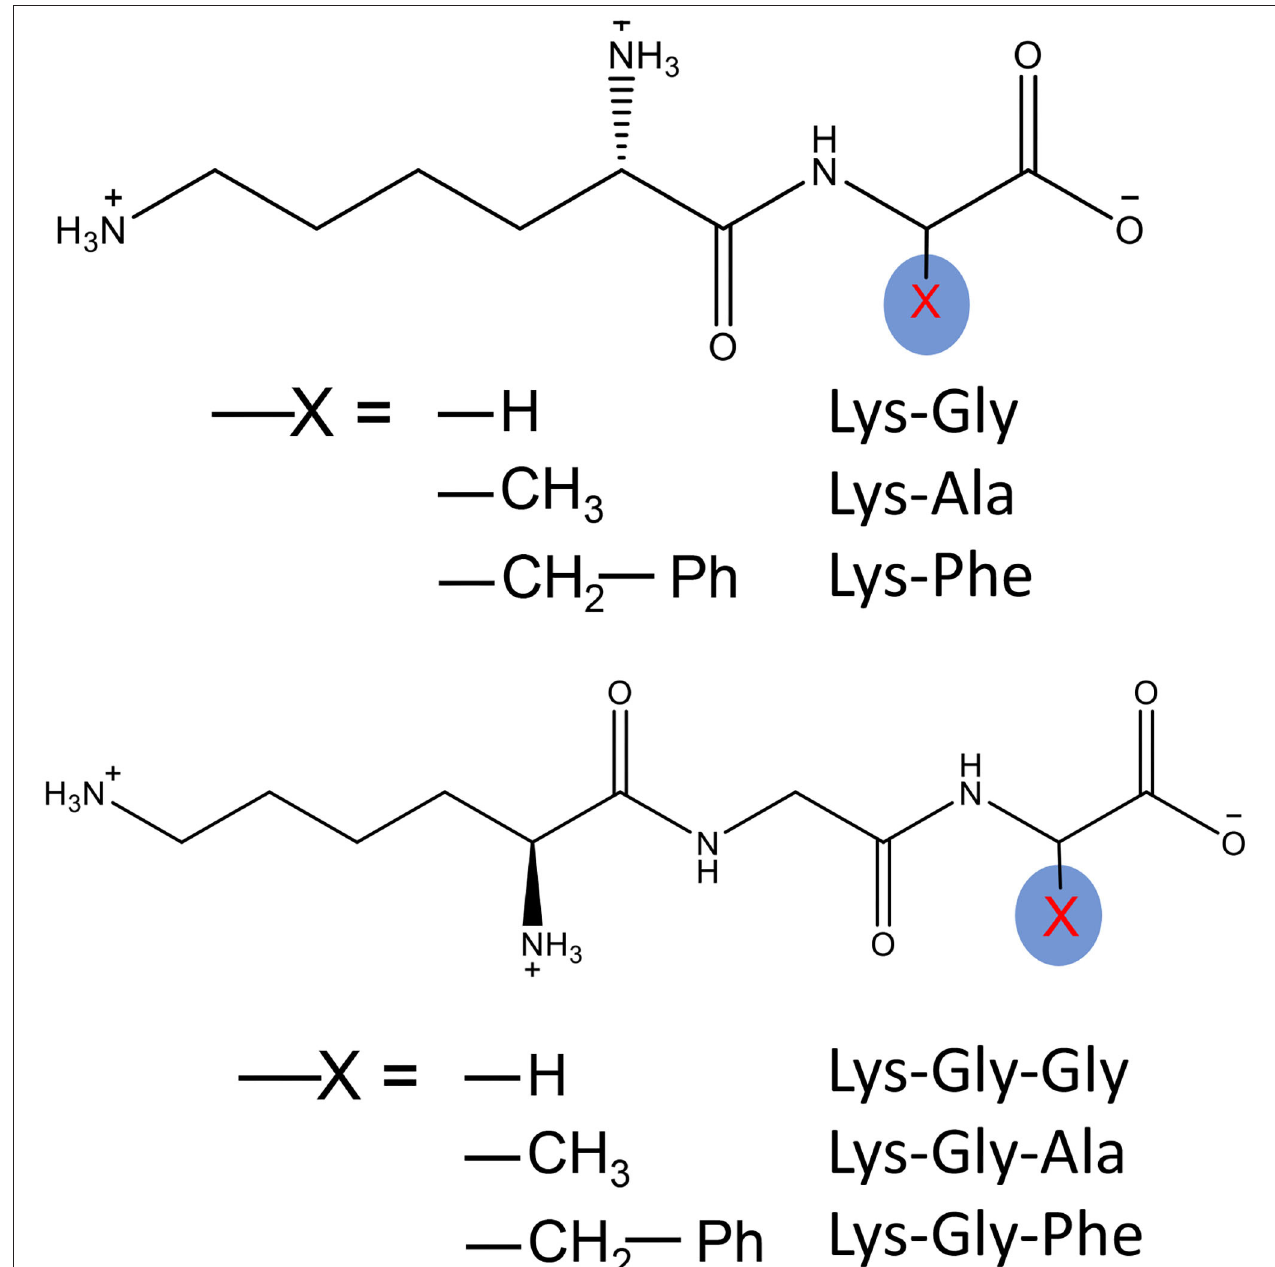
FIGURE 1 | The dipeptides and tripeptides and their